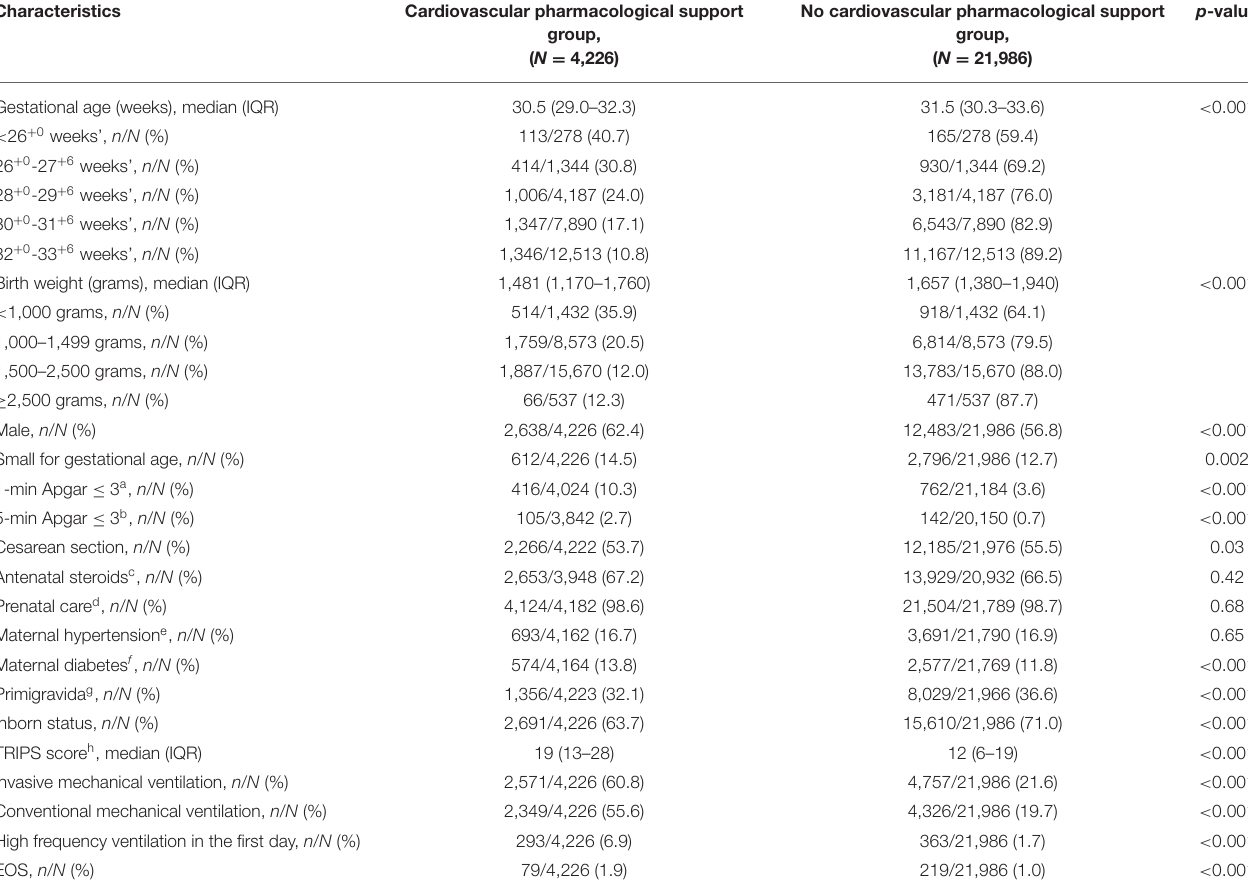
TABLE 1 | Characteristics of the study population. Characteristics Cardiovascular pharmacological support